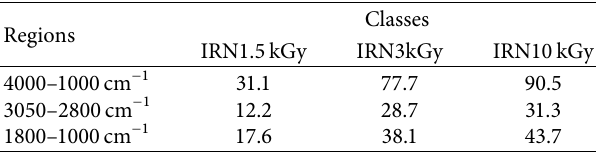
Figure 3: PCA score plots for control, 1.5 kGy irradiated, 3 kGy irradiated, and 10 kGy irradiated hazelnut samples in the (a) 4000–1000, (b) 3050–2800, and (c) 1800–1000 cm − 1 spectral regions. Table 1: Distances of the centroids of 1.5kGy, 3 kGy, and 10kGy irradiated classes from the centroid of control samples.